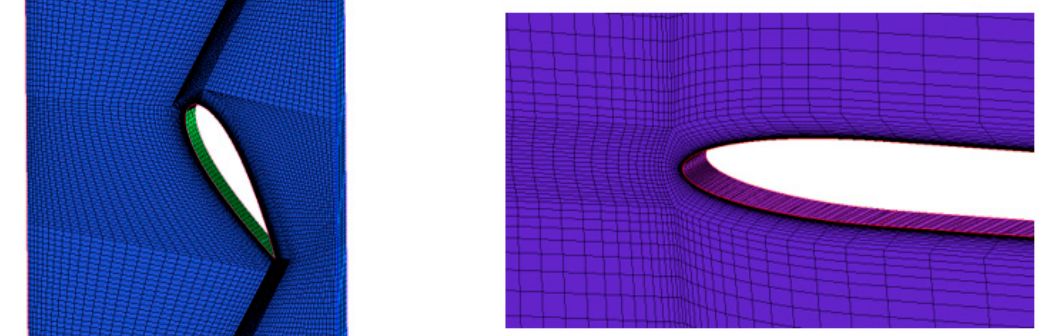
Figure 3. Snapshot of boundary layer mesh encryption ( left : airfoil blade, right : flat plate).